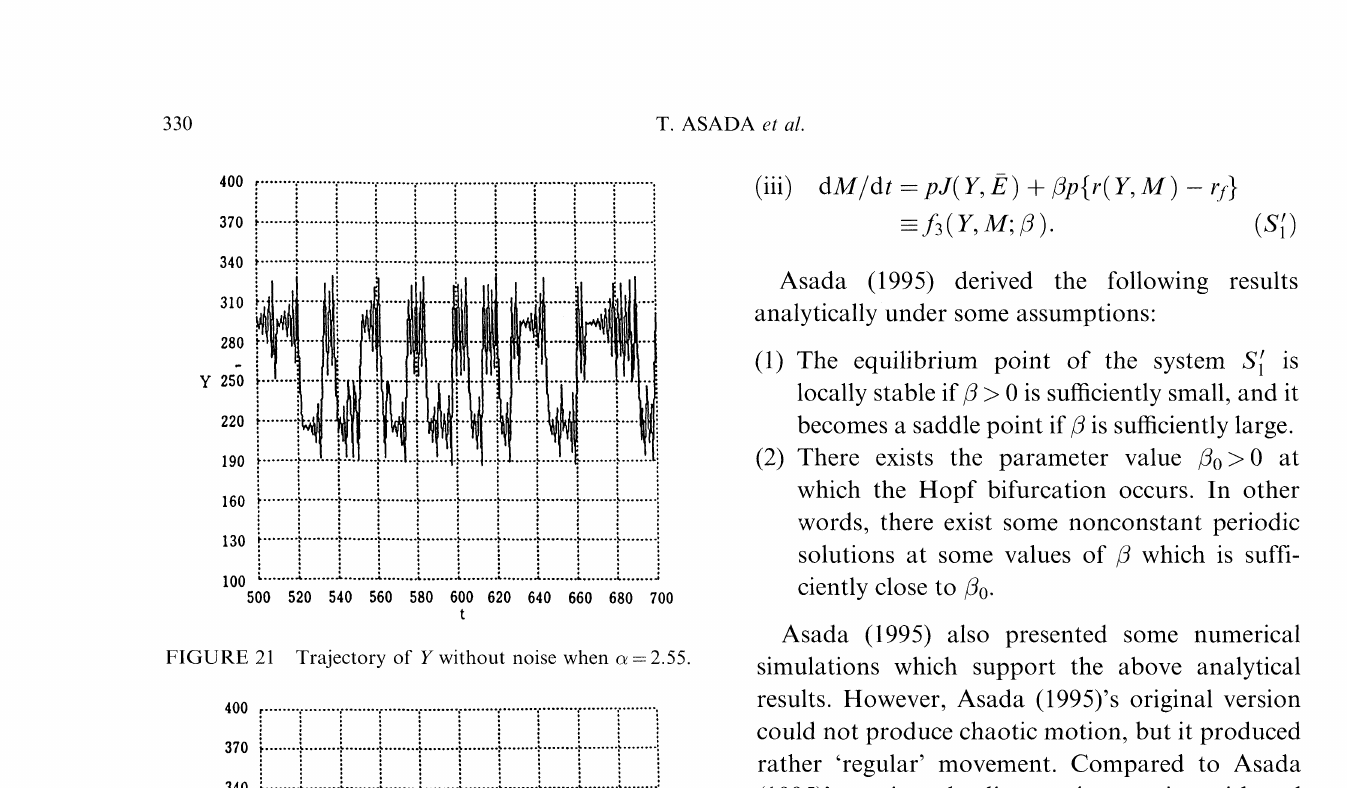
FIGURE 22 Trajectory of Y with noise when c=2.55 (=